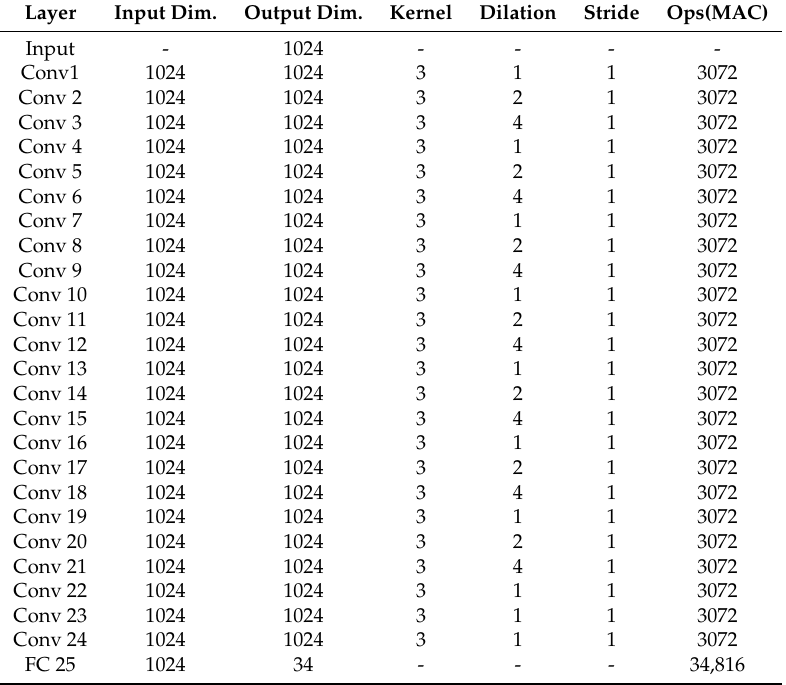
Figure 5. Histogram of value distribution: the horizontal axis indicates the range of values, and the vertical axis indicates the occurrences. We noticed that the values of the parameters were mainly concentrated in a very small interval, which was the basis of the quantization. Table 7. Structure of the final